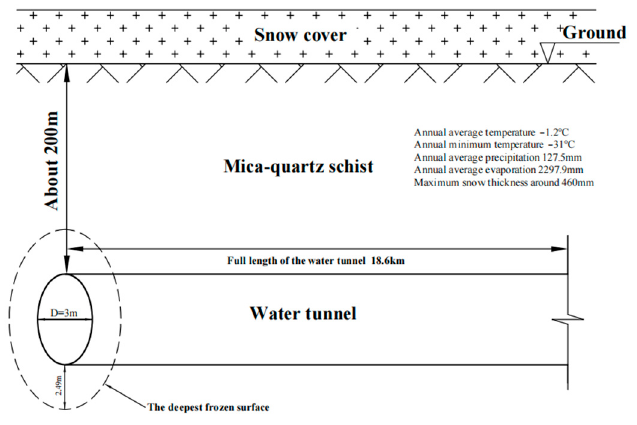
Figure 1. Working condition diagram of underground water tunnel of a hydropower station in Xinjiang.